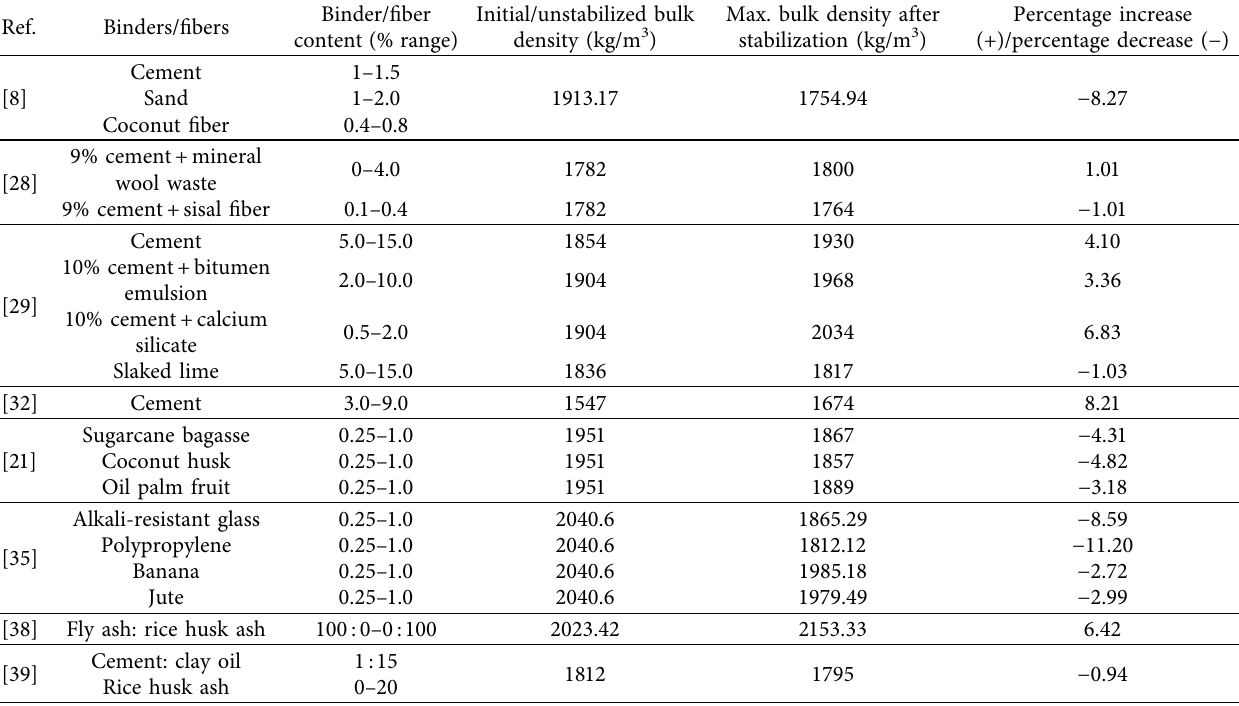
Table 7: Bulk density of unfired admixed soil blocks as reported in the reviewed articles.